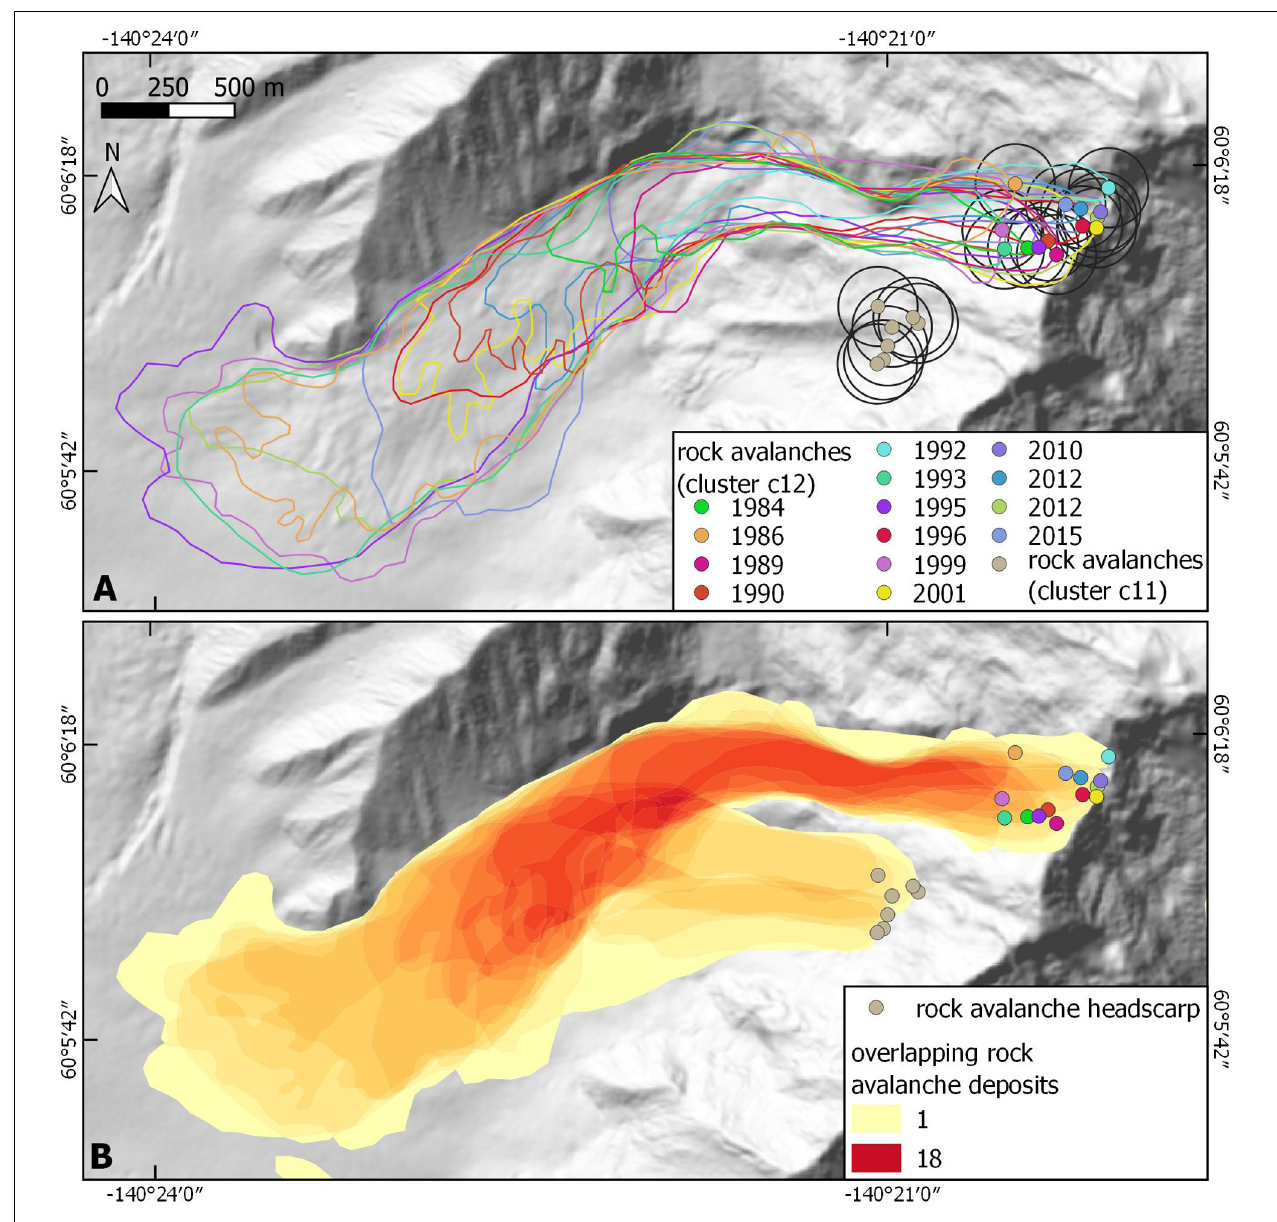
FIGURE 9 | (A) Closeup of the Hitchcock Glacier showing mapped headscarp locations for rock avalanche clusters c11 (gray dots) and c12 (colored dots) and deposits (colored lines) for cluster c12. Black circles denote a 150 m buffer zone around each headscarp point, indicating the extent of possible mapping error. (B) Heat map showing the number of overlapping rock avalanche deposits from clusters c11 (gray headscarp points) and c12 (colored headscarp points) on the Hitchcock